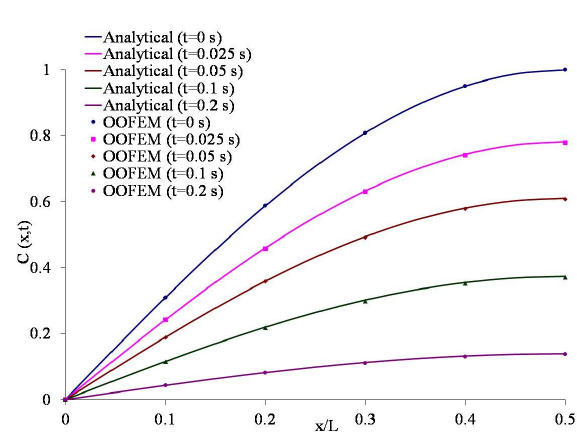
Fig. 2. 1D Chloride ions diffusion